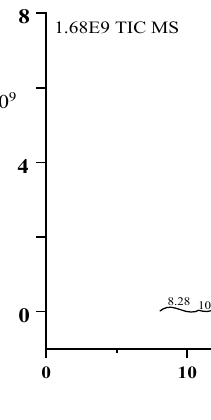
Figure 6. The GC-MS total ion current (TIC) chromatogram. The numbers above the peaks indicate the retention time for each compound. Table 3. The results of GC–MS analysis of the EtOAc fraction.